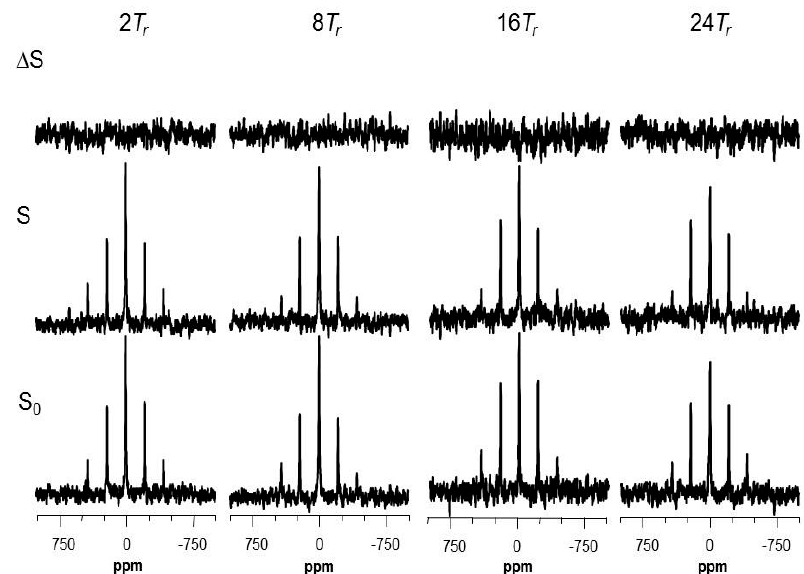
Figure 5. 2 H{ 19 F} REDOR spectra of the microtubule-bound analog 3 as a function of dipolar evolution with magic-angle spinning at 13,000 Hz, full-echo ( S 0 ), dephased-echo ( S ), and difference ( Δ S ) spectra. Dipolar evolution times are marked in multiples of the rotor period ( T r ). The acquisition scans for the 2, 8, 16, and 24 T r experiments were 81,920, 163,840, 163,840, and 368,640, respectively. The NMR experiments were performed at ambient temperature.